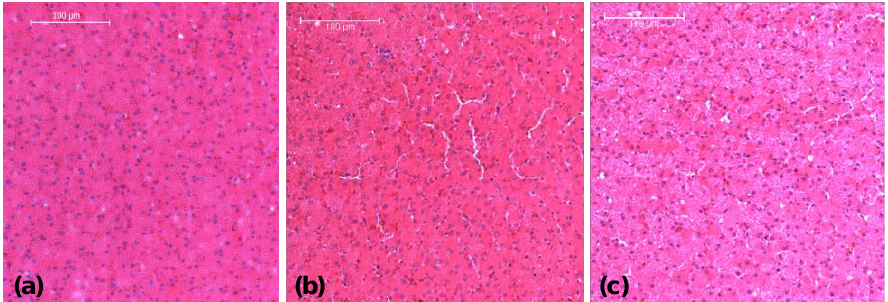
Table 3. Image analysis results from Figure 4a – c revealing the tissue’s homogeneity and isotropy.